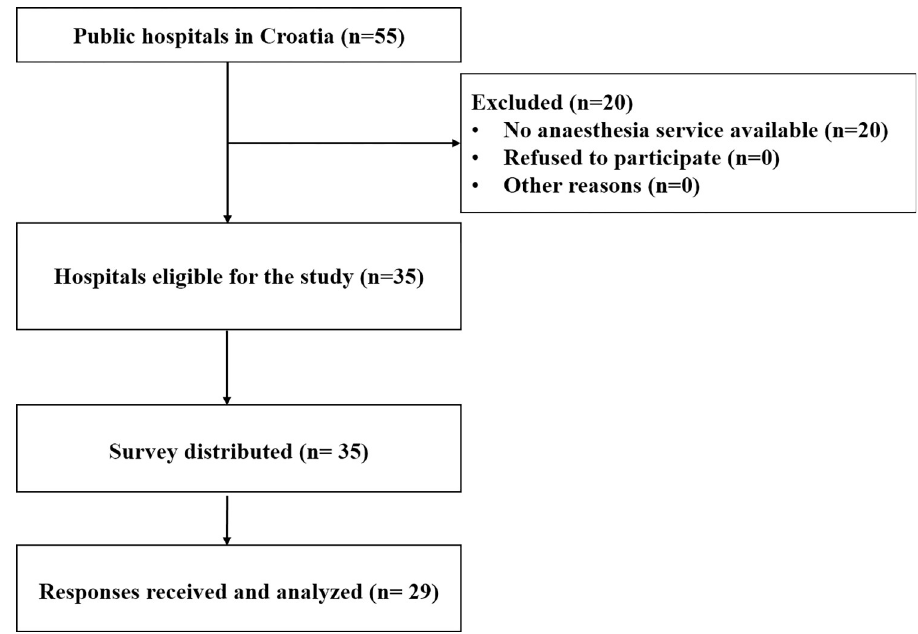
Fig 1. Flow diagram of the